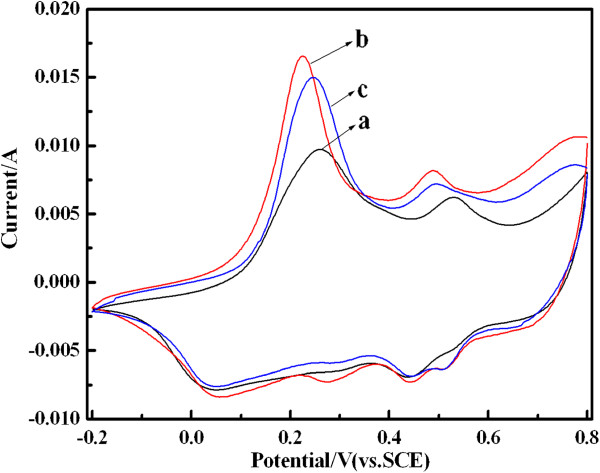
CV curves of PANI (a), PANI(HAuCl4·4H2O) (b), and PANI(H2PtCl6·6H2O) (c) in 1 M H2SO4 electrolyte. Scan rate is 3 mV s−1. Mass of the active material is 3 mg, and graphite current collector was used (area 1 cm2) as the working electrode.